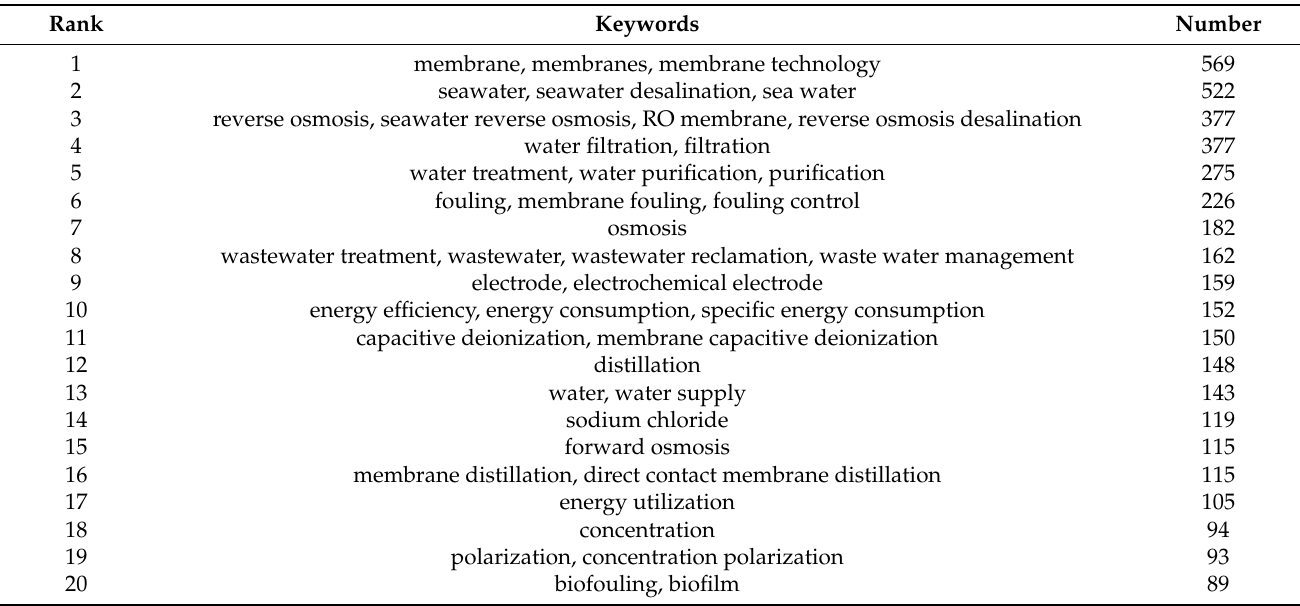
Figure 2. Trends of scientific publications related to desalination globally and from South Korea. Table 3. Top 20 keywords for desalination research in South